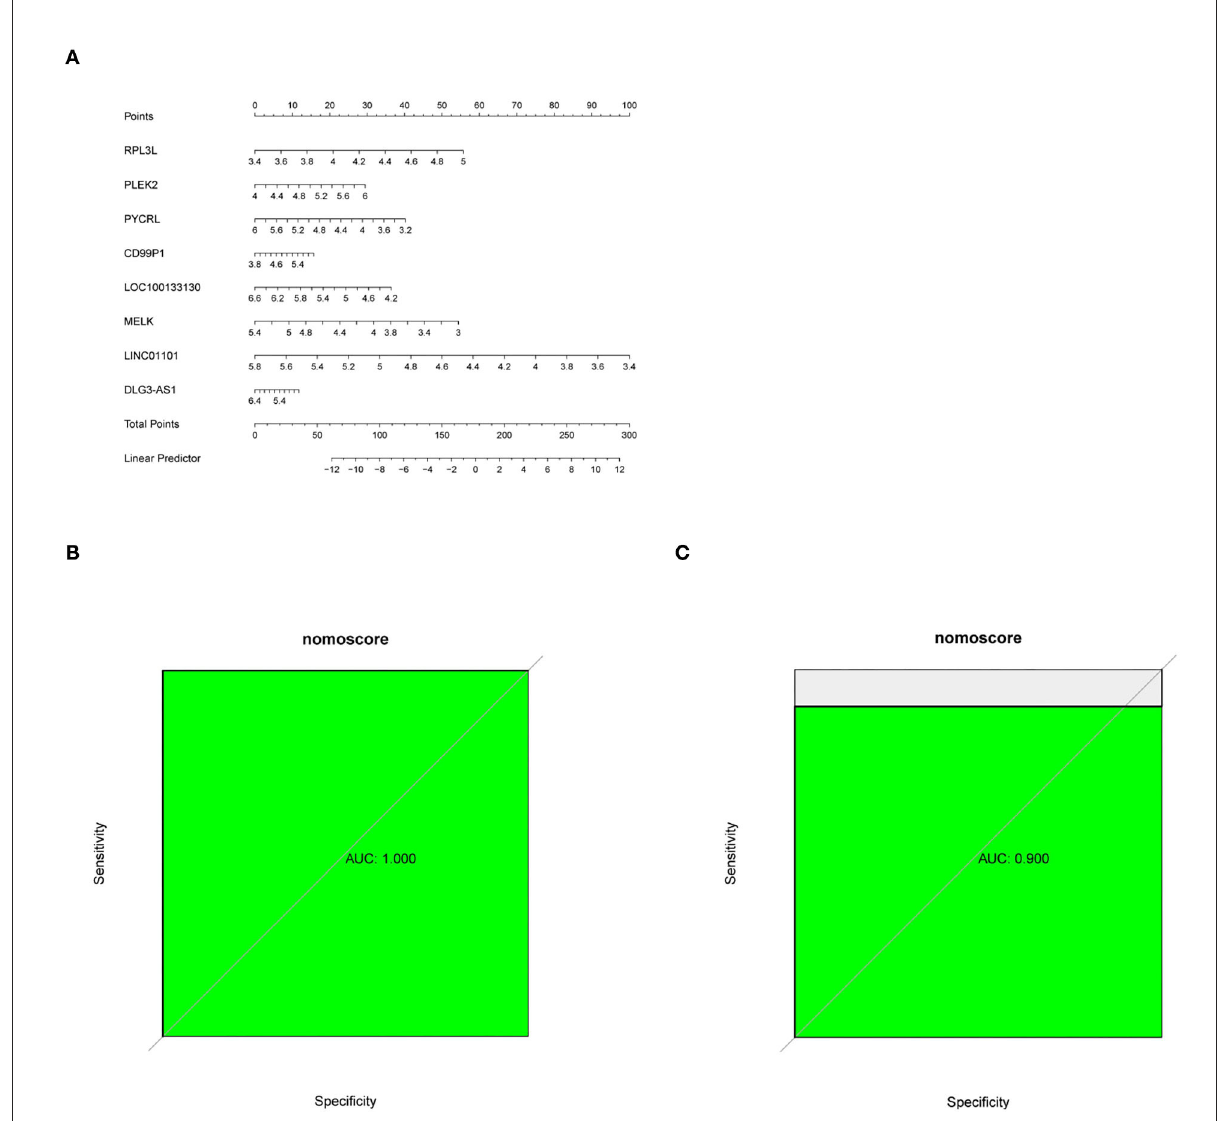
FIGURE5 (A) Nomogram predicting PD probability. (B,C) ROC curve for the GSE7621 dataset and GSE20141